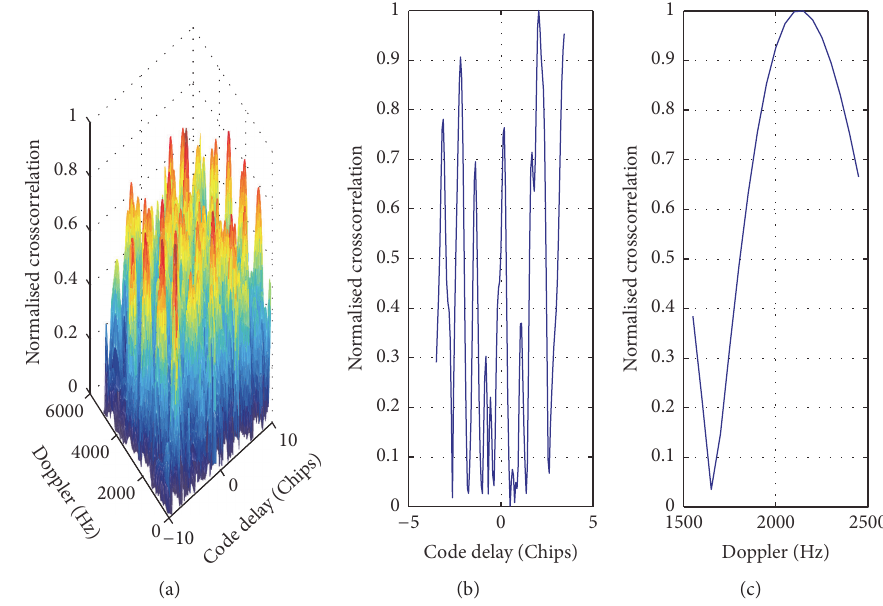
Figure 21: Correlation peaks after interference suppression by ST-MPDR beamformer for scenario 3.